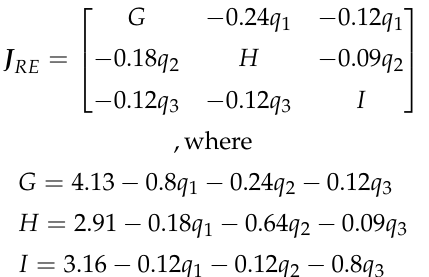
Table 1. Exogenous variables.